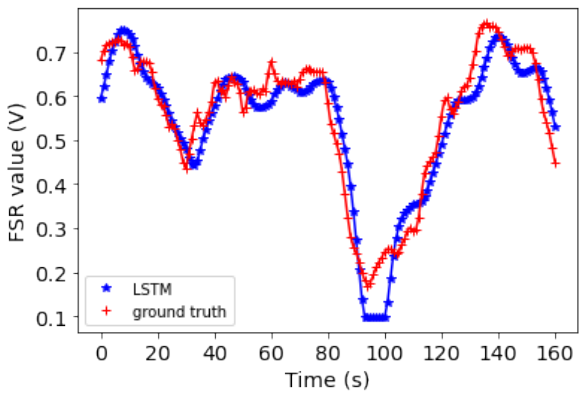
Figure 10. Subject 2: The 1D-CNN-LSTM forecasting values for the next 162 s (blue points) plotted against the actual values (red points) for FSR Number 5.